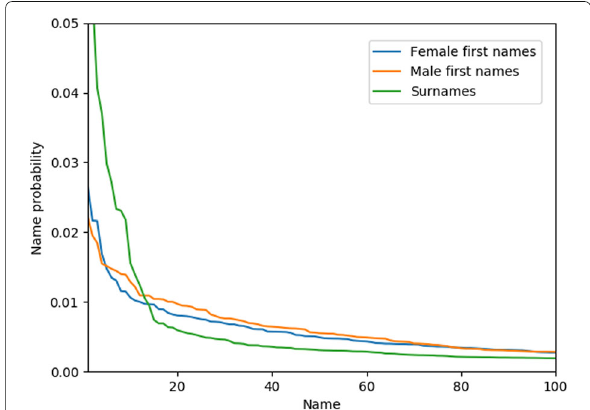
Fig. 5 Truncated most common name distribution for males and females in